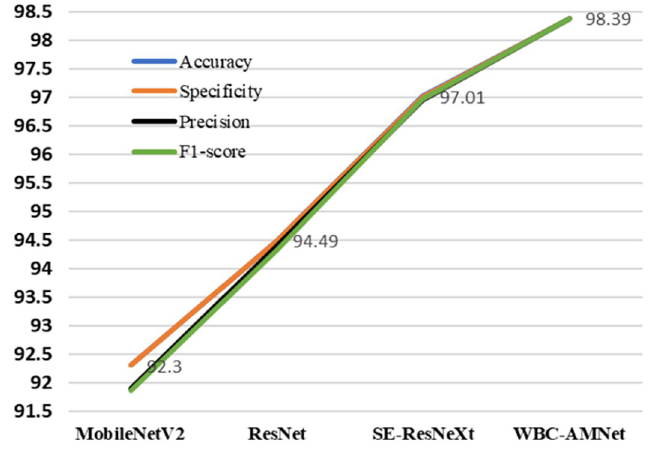
Fig 10. Quad-classification line chart of WBCs